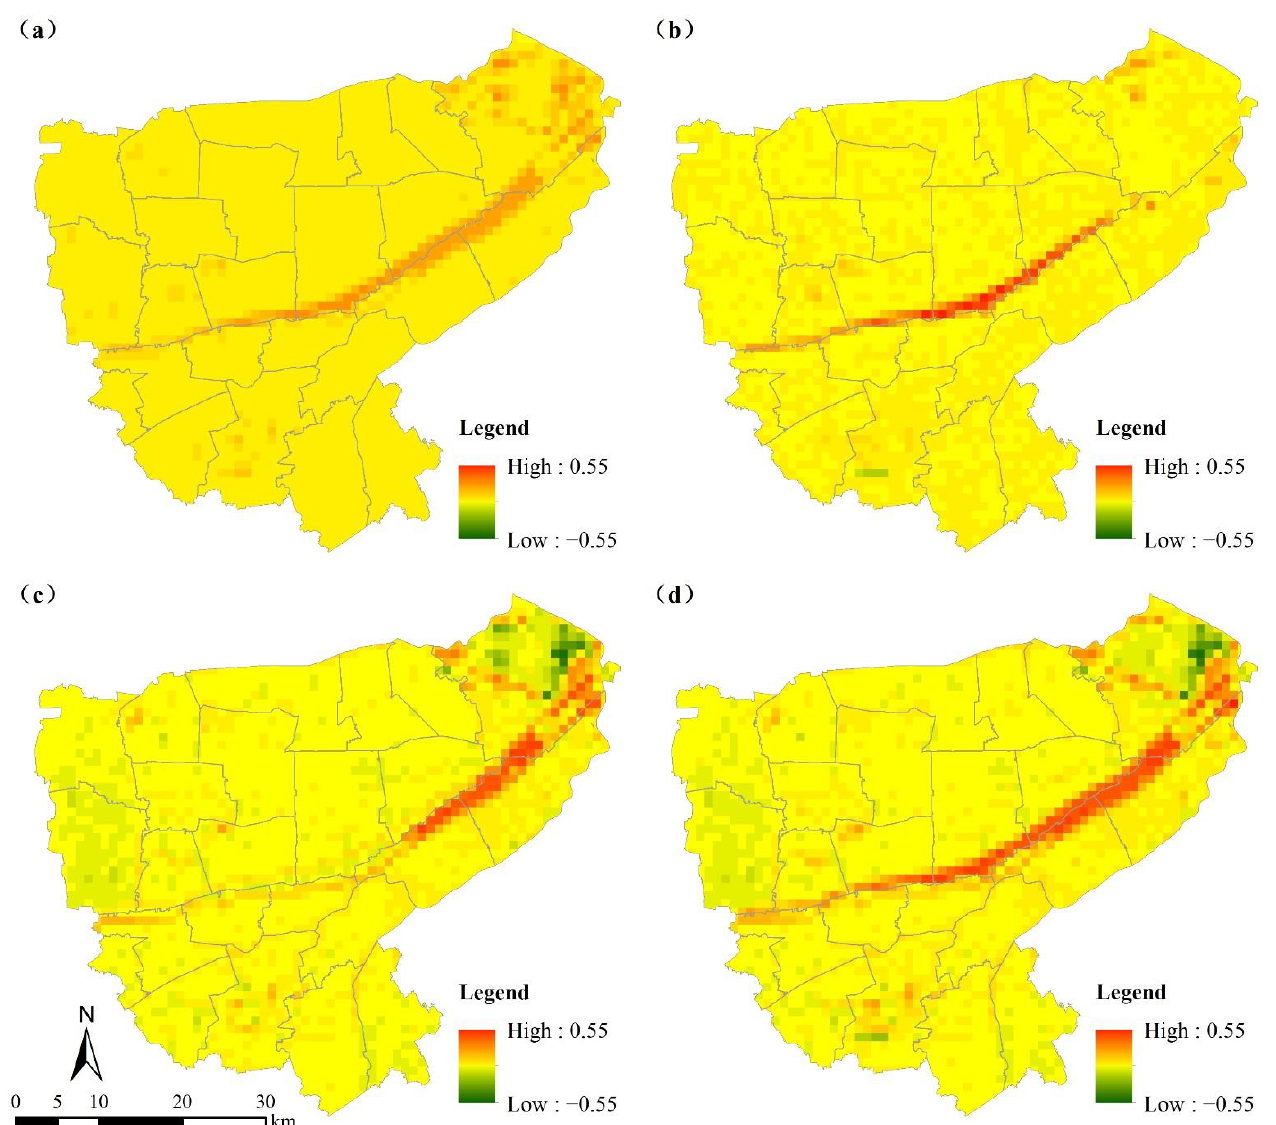
Figure 10. The changes in human disturbance in the spatial dimension from 2009 to 2020. ( a ) The human disturbance stability from 2009 to 2020. ( b ) The changes in the period from 2009 to 2014. ( c ) The changes in the period from 2014 to 2020; ( d ) The changes in the period from 2009 to 2020.